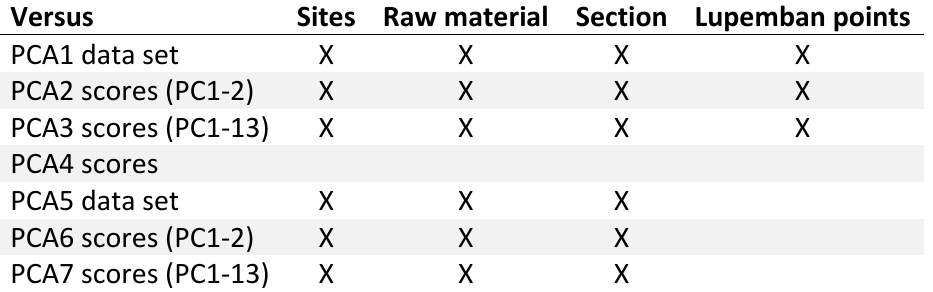
Table 3. Summary of the data used (dependent variables and independent variables) in the